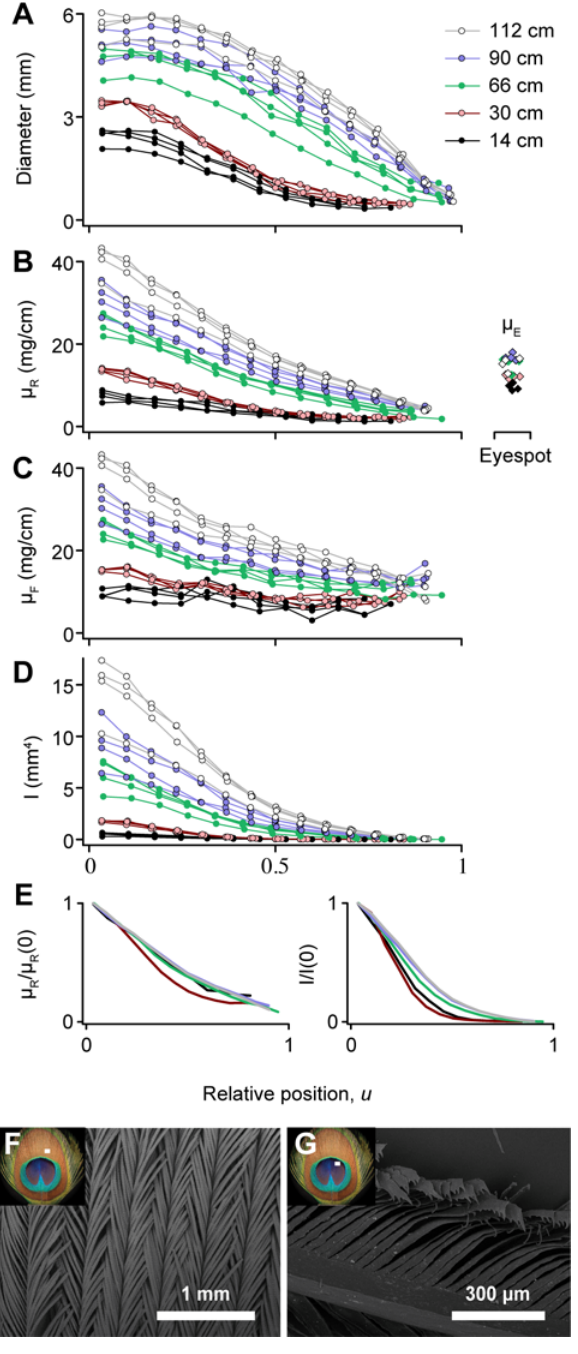
Fig 8. Morphometrics, mechanical parameters, and ultrastructure of eyespot feathers. Plots A-D show how feather morphology ( n = 4 feathers of each length) varies with position along the rachis, x , rescaled to be a fraction of rachis length, u = x / L R : (A) rachis diameter, D 1 , in the lateral plane (parallel to the barbs), (B) linear density of the rachis, μ R , (C) linear density of the entire feather, μ F , and (D) second moment of area for the rachis in the lateral direction, I , computed from the diameter and linear density data. Linear density of the eyespots, μ E , is shown to the right of the rachis data in B. To compare the functional forms for μ R and I for different length feathers, the plots in E show the average values of I and μ R rescaled for each feather to have a value of one at u = 0. SEM images show that peacock eyespots have (F) intermeshed barbules and (G) microhooks that help the eyespot move as a single unit. Insets indicate the approximate locations of the barbules shown in the SEM images with white